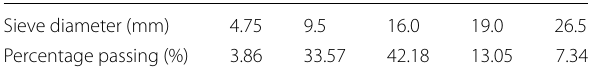
Table 1 Coarse aggregate